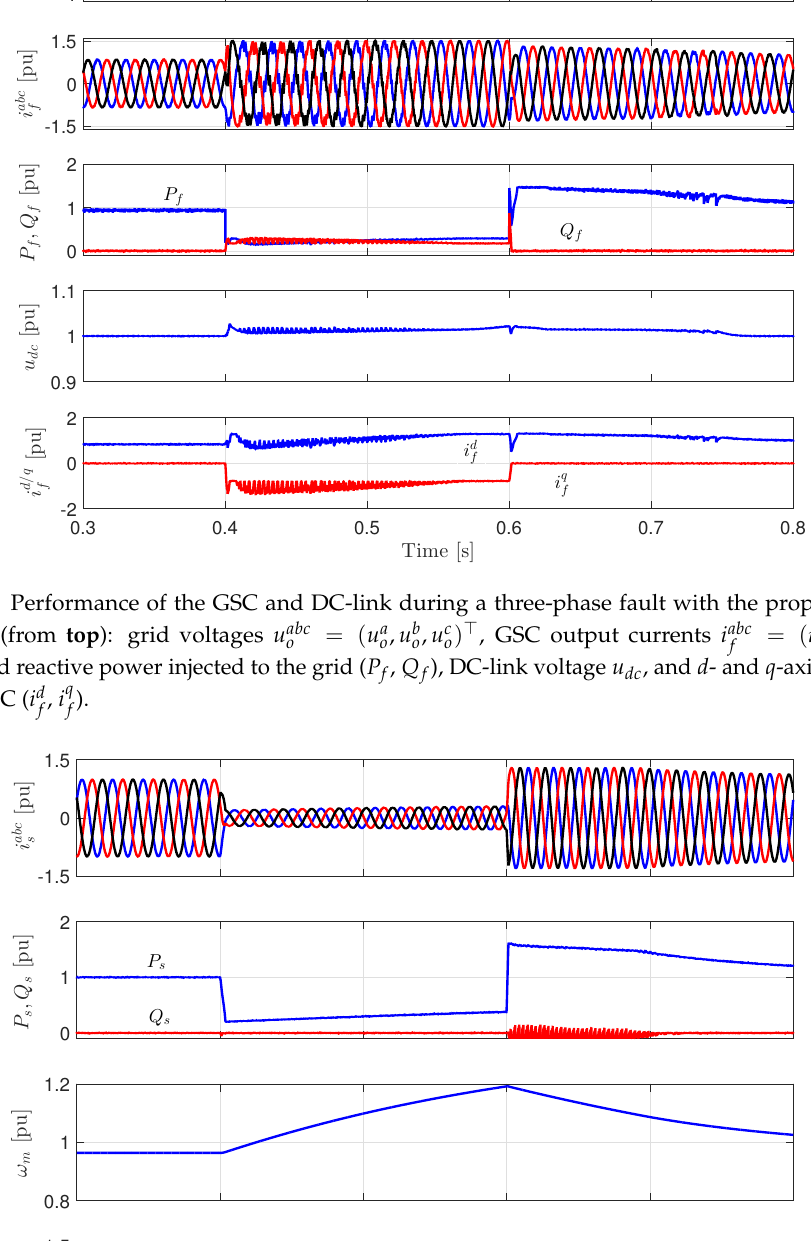
Figure 7. Performance of the MSC and PMSG during a three-phase fault with the proposed FRT strategy (from top ): PMSG output currents i abc s = ( i a s , i b s , i c s ) (cid:62) , PMSG active and reactive power ( P s , Q s ), mechanical speed of the PMSG rotor ω m , and d - and q -axis currents of PMSG ( i d s , i q s